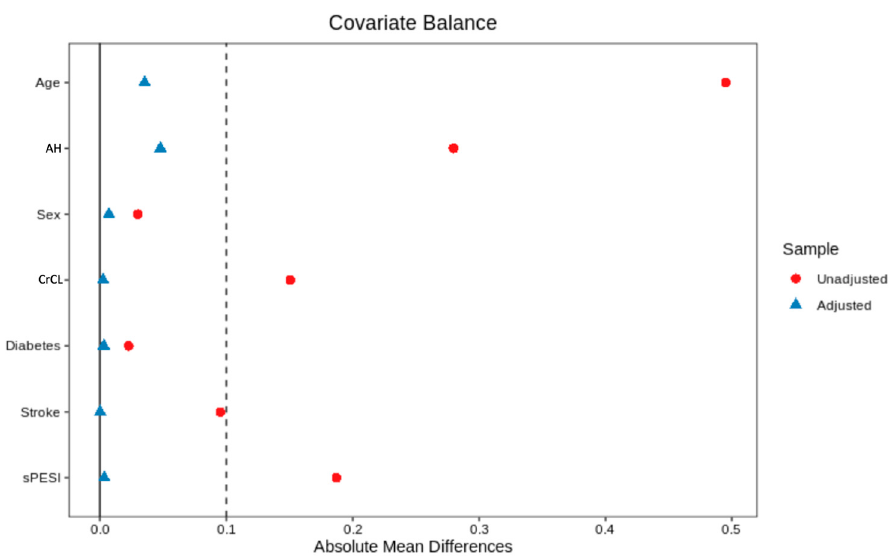
Figure 2. Standardized mean difference (SMD) before (red) and after (blue) inverse probability weighting from propensity scores. AH: arterial hypertension; CrCl: Cockcroft clearance of creatinine; sPESI: simplified Pulmonary Embolism Severity Index.